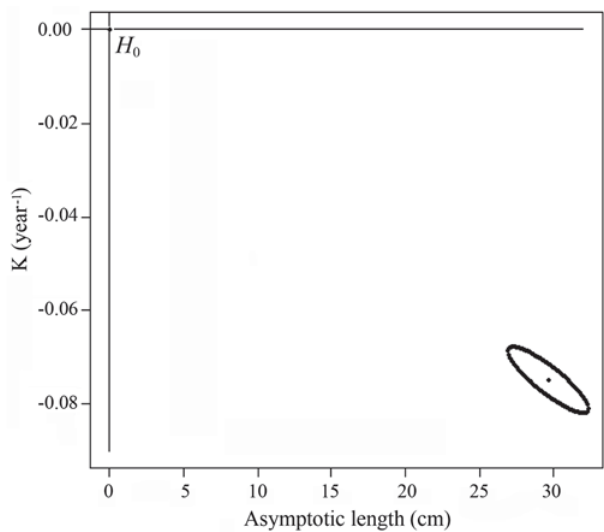
Fig. 9. Cross section of approximate 95% confidence intervals calculated for the difference between the vectors of the growth parameters ( L , K) ( T 2 of Hotelling) for females and males of ∞ Scomberomorus brasiliensis collected off northeastern Brazil.